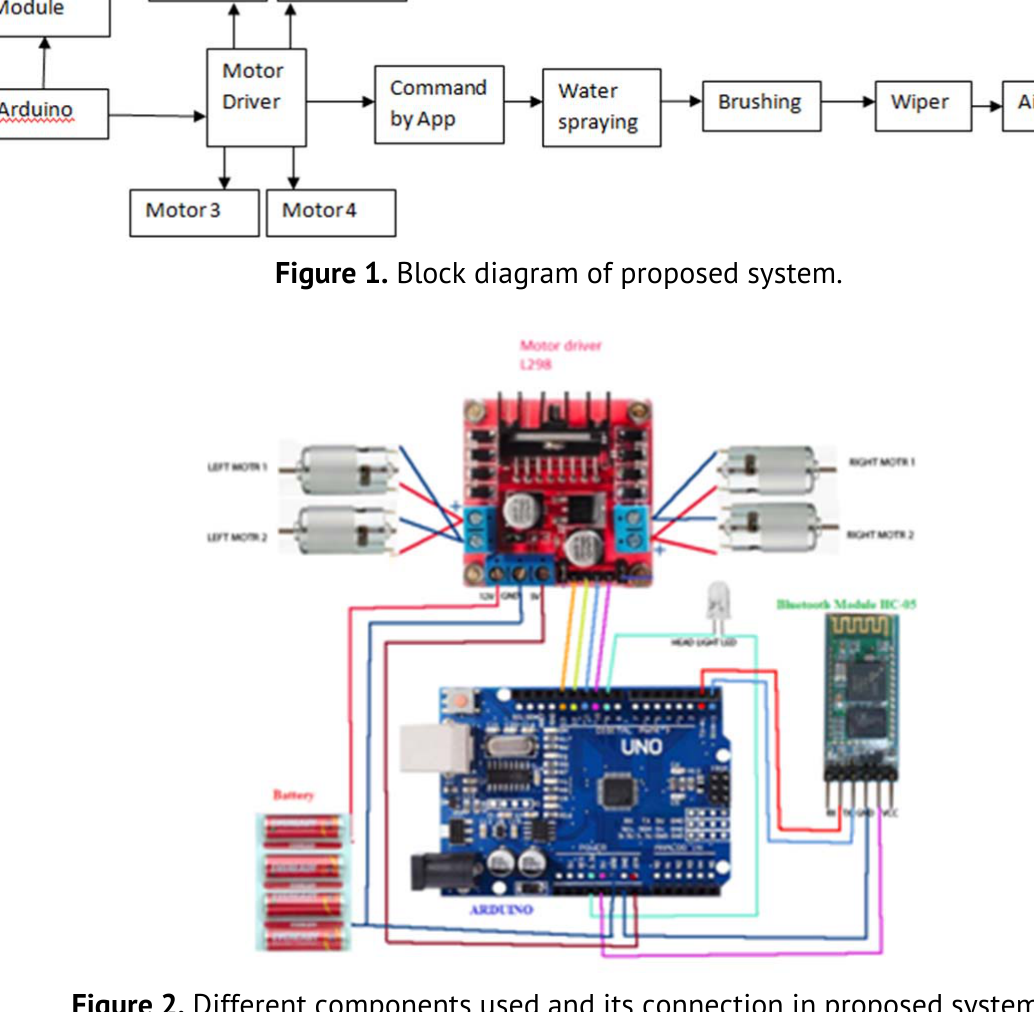
Figure 2. Different components used and its connection in proposed